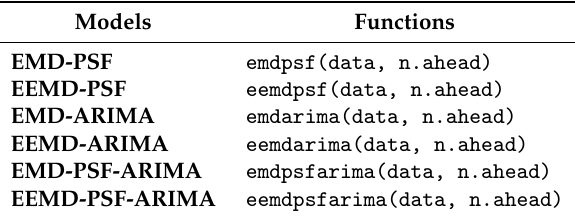
Table A1. Functions for respective models in ‘decomposedPSF’, an R